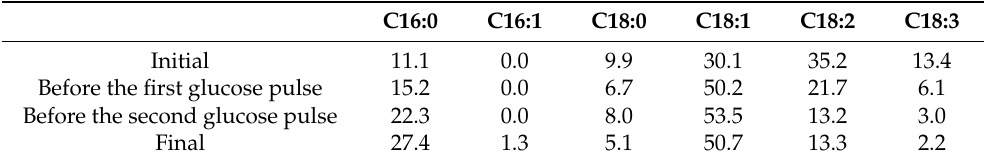
Table 6. Fatty acid composition represented as % ( w / w ) of the total lipid produced by C. curvatus before and after the fermentation process and before each glucose pulse.